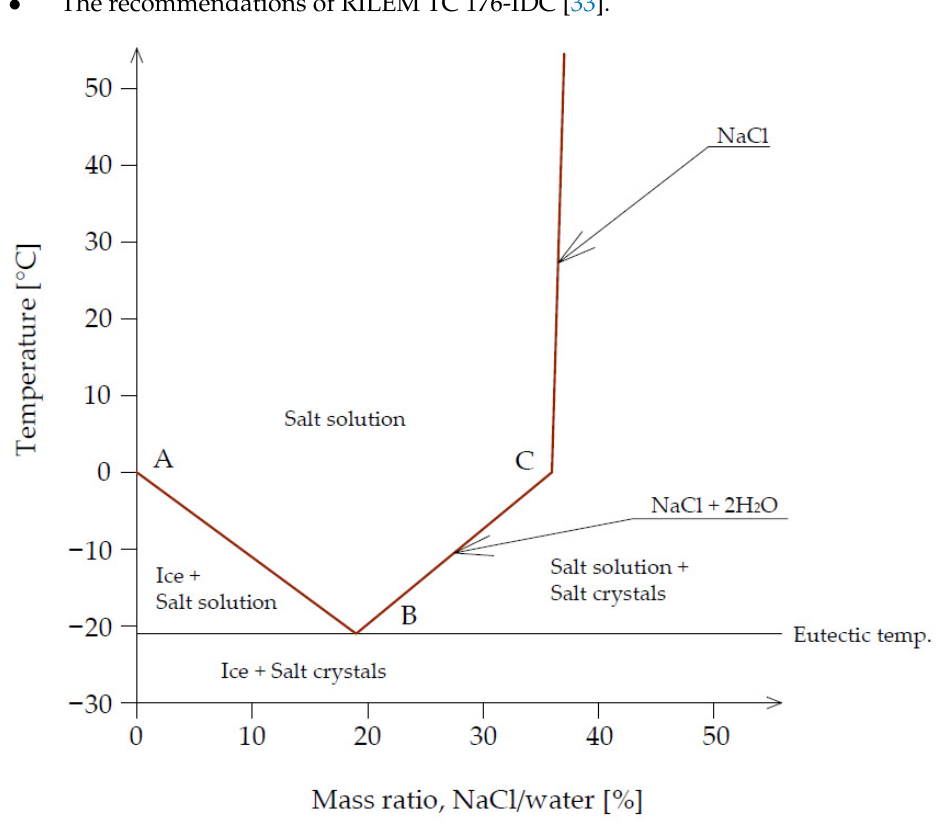
Figure 1. Phase diagram of NaCl solution according to Werse .